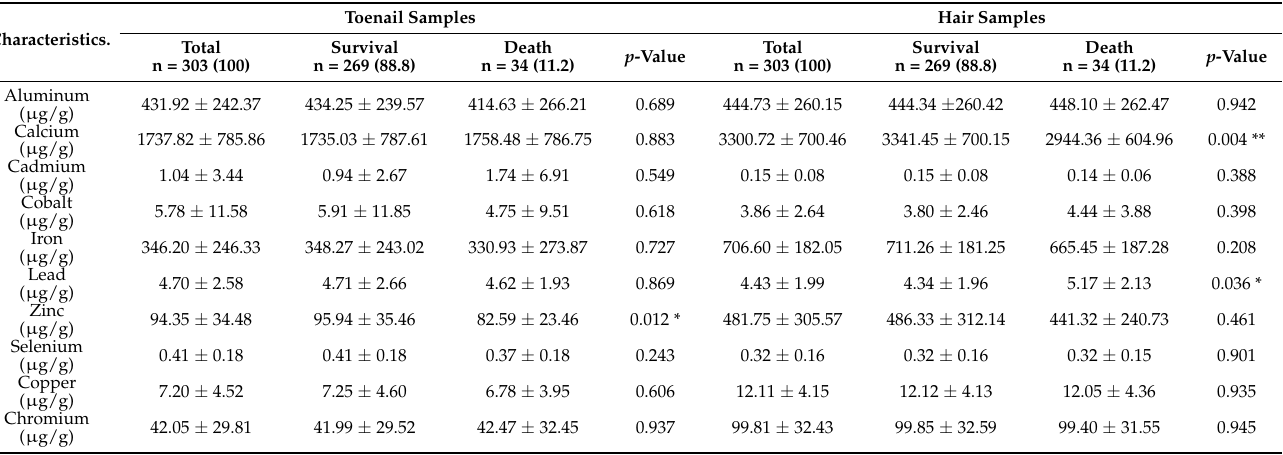
Table 3. Levels of various trace elements in toenail and hair samples between the participants who survived and those who